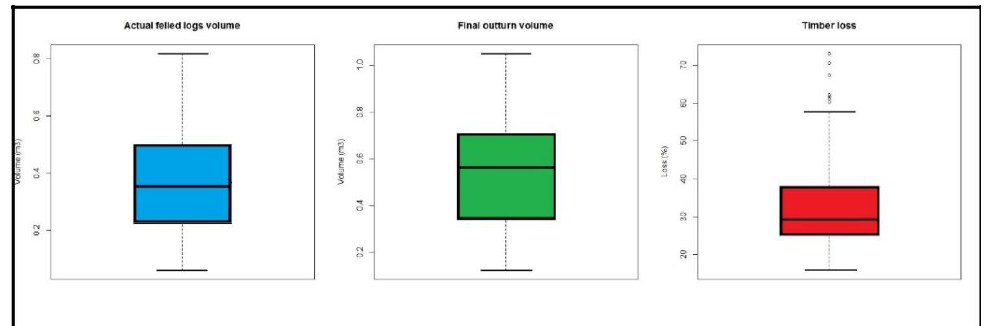
Figure 4. Box plots showing variations in actual felled log volume, final outturn volume, and timber losses in log sawing stage.